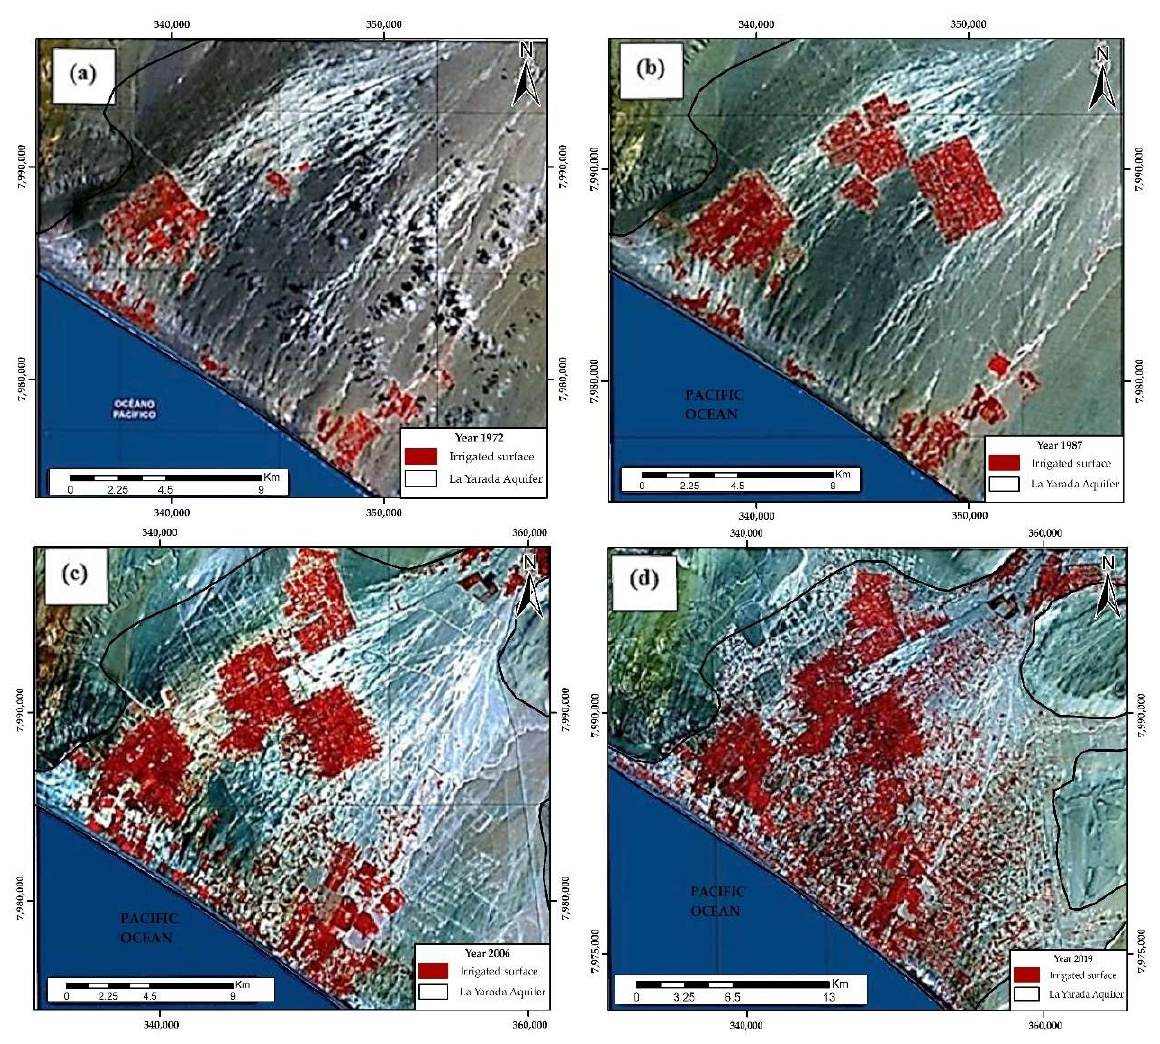
Figure 2. Evolution of irrigated area during ( a ) 1972, ( b ) 1987, ( c ) 2006 and ( d ) 2019, the sustained increase in the cultivated area is evidenced, and the corresponding increase in the exploited volume of the aquifer [21].